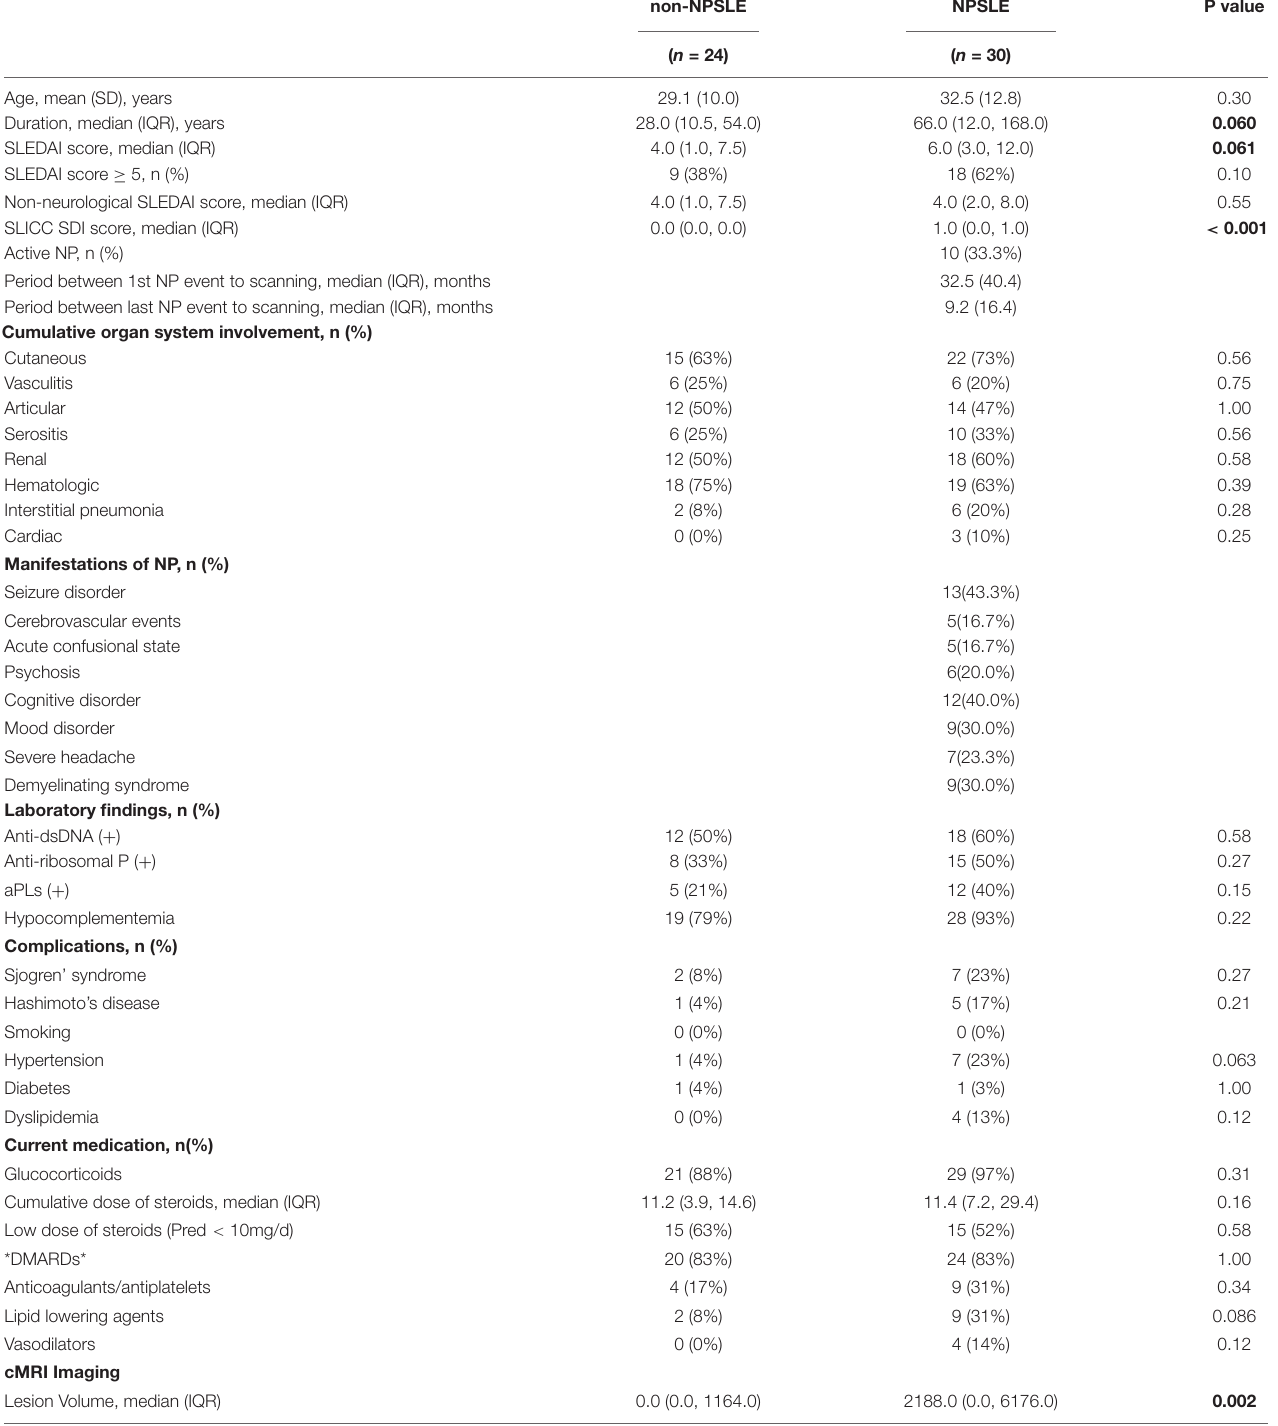
TABLE 1 | Demographic and clinical characteristics of SLE patients with and without neuropsychiatric manifestations.